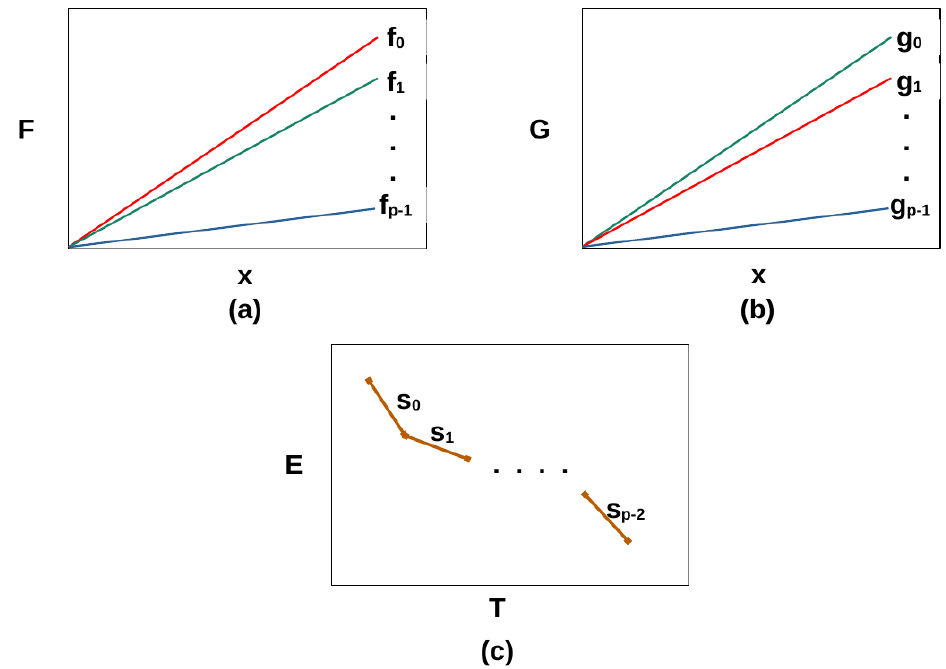
Figure 4. Consider the bi-objective optimization problem for performance and energy for p heteroge- neous processors characterized by p linear increasing time functions, { f 0 , · · · , f p − 1 } , in set F , and p linear increasing energy functions, { g 0 , · · · , g p − 1 } in set G . ( a ). The set of p linear increasing time functions, { f 0 , · · · , f p − 1 } , in set F . ( b ). The set of p linear increasing energy functions, { g 0 , · · · , g p − 1